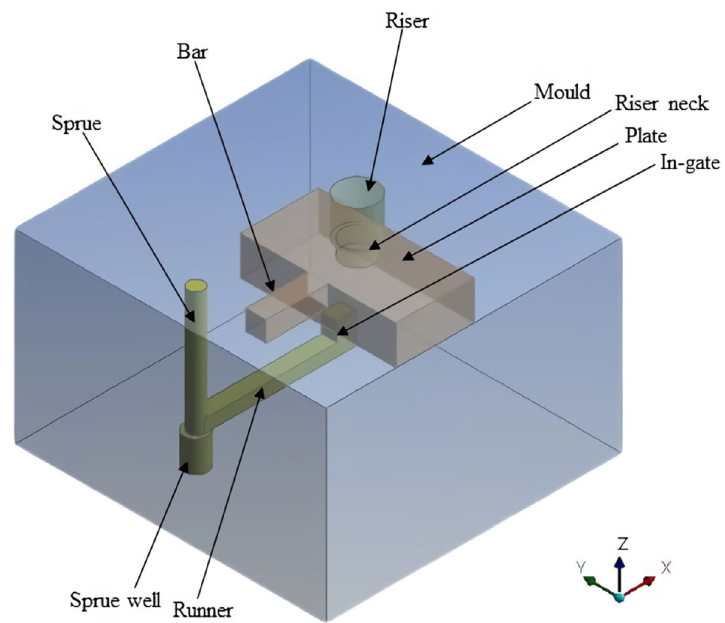
Fig. 1 Bottom gating casting used by Mozammil et al. [15]